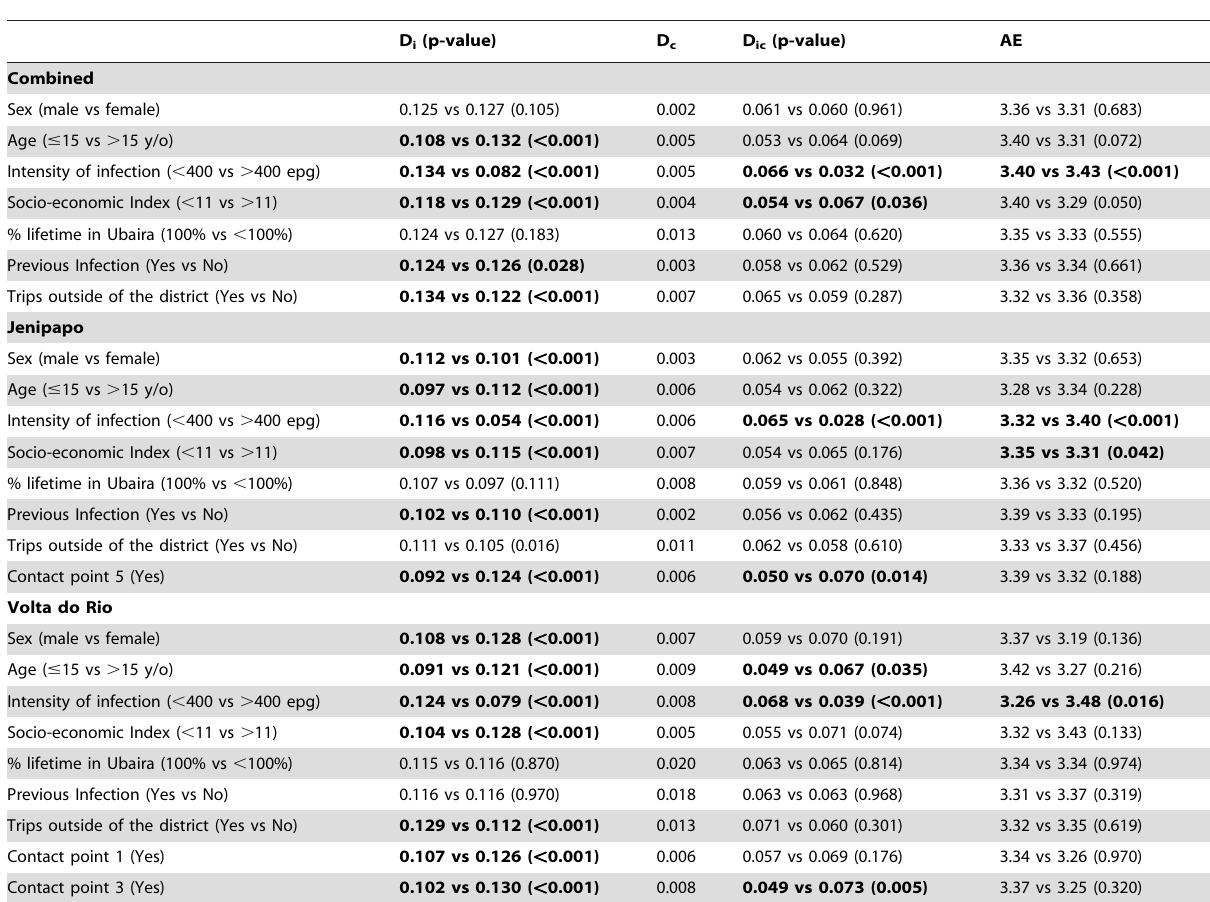
Table 4. Subpopulation differentiation and